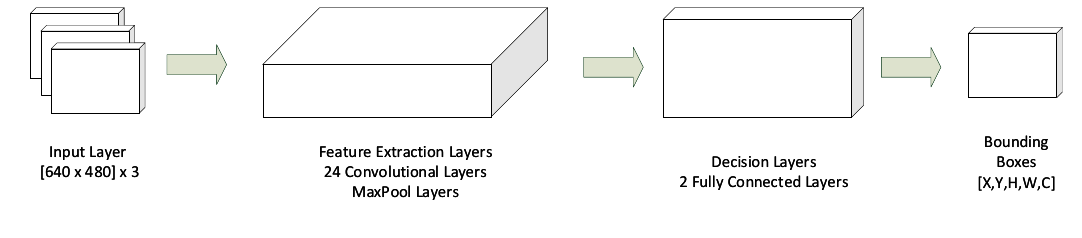
Figure 5. The YOLO network